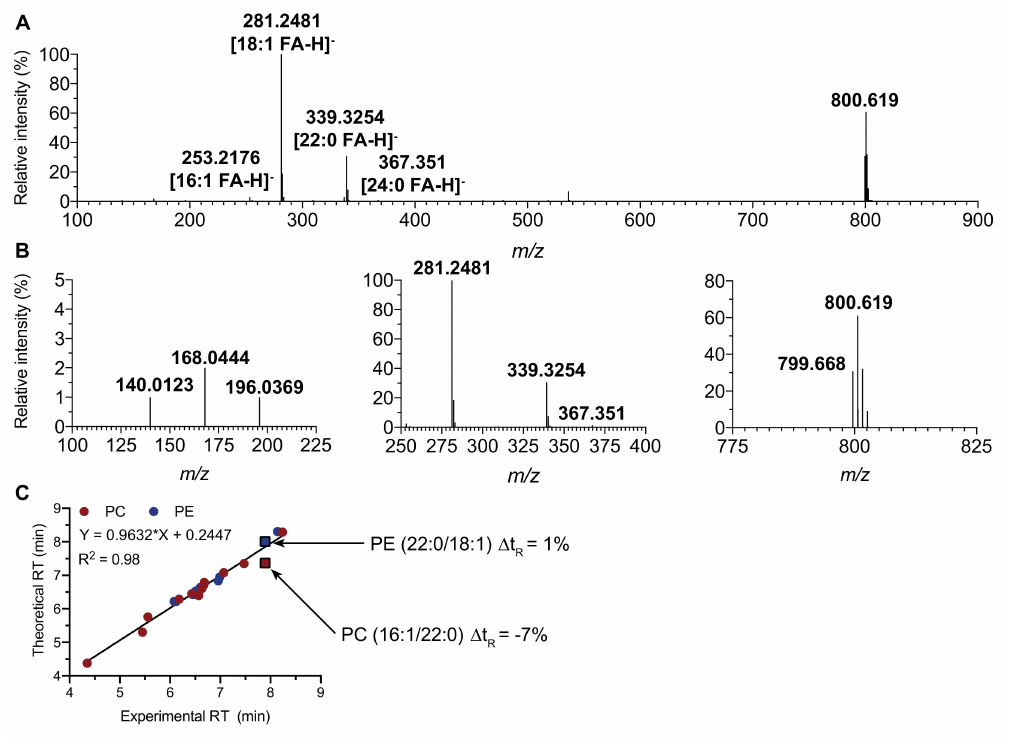
Figure 6. Retention time prediction use to discriminate two isobaric PE and PC species. ( A ) MS / MS spectrum of PE (40:1) [M − H] − ion ( m / z 800,619). ( B ) Low, middle, and high mass region of the spectrum A. ( C ) Theoretical t R plotted against experimental t R for standard PC and PE species (circles) and for PE (22:0 / 18:1) and PC (16:1 / 22:0)